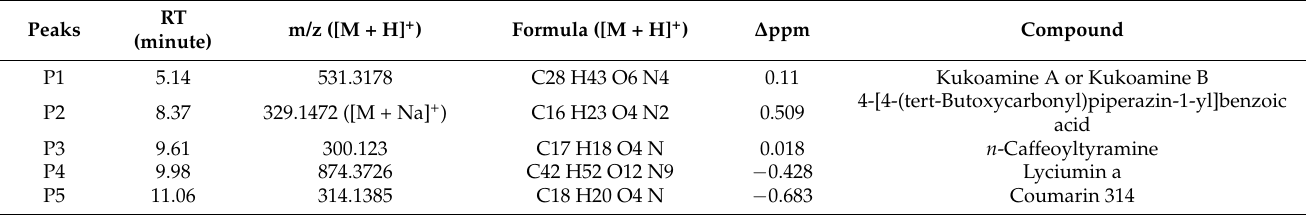
Table 1. Chemical profile of major compounds in